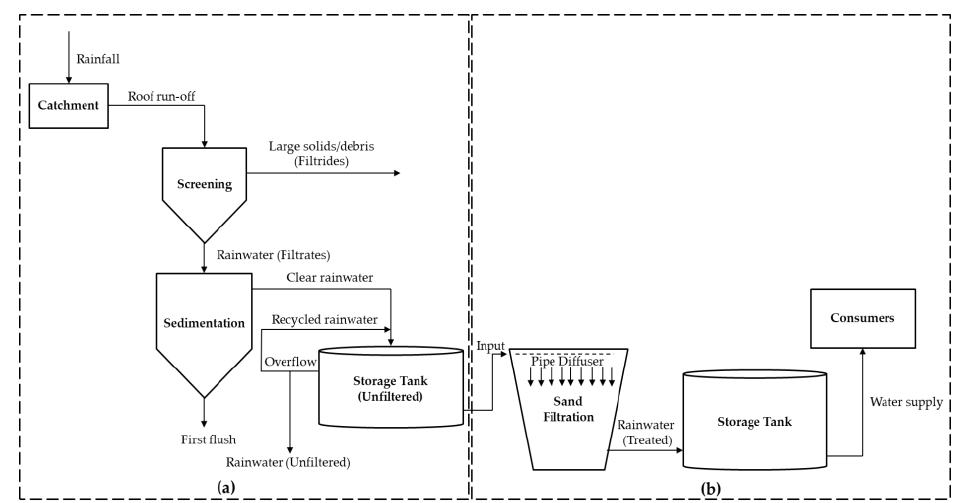
Figure 2. Process flow diagram for the ( a ) rainwater harvesting system (RWHS) and ( b ) water treatment system (WTS) .